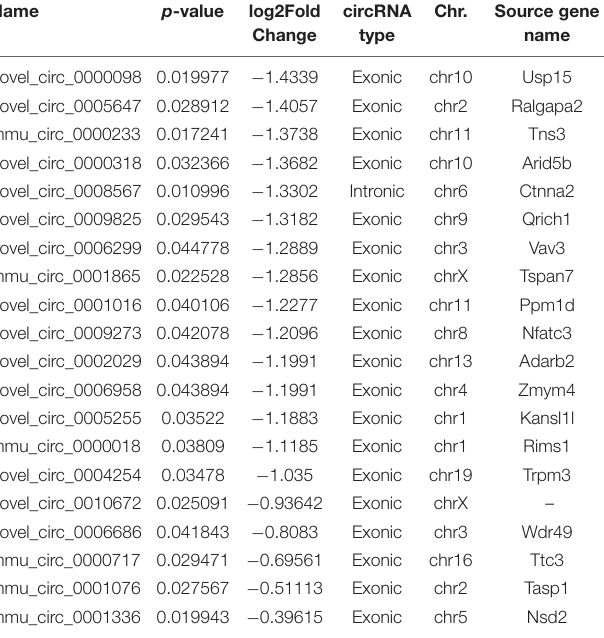
TABLE 1 | Differently expressed circRNAs between APP/PS1 and WT